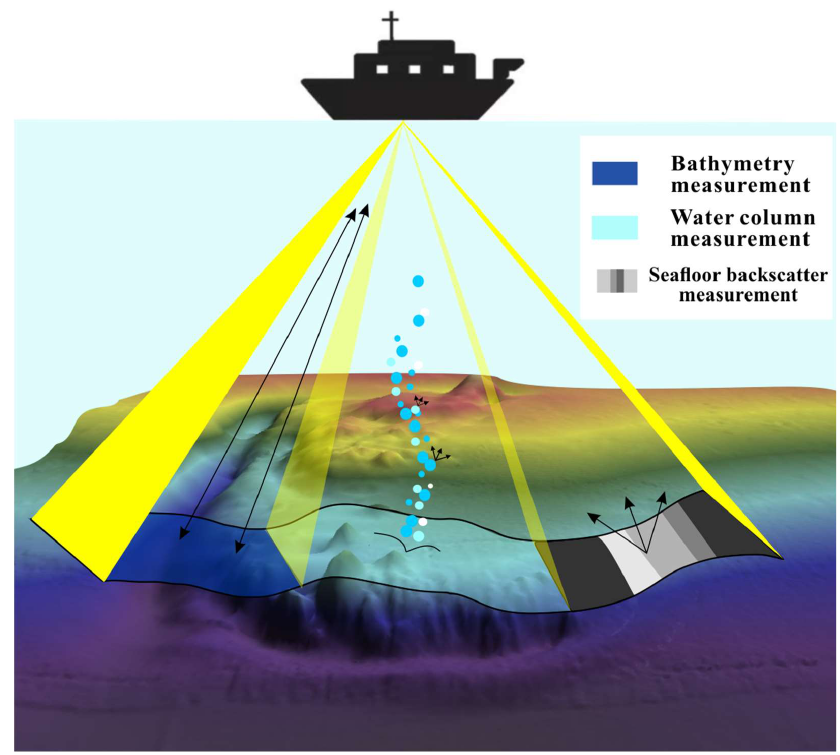
Figure 1. A diagram of different types of acoustic data recorded by MBES. Adapted with permission from ref. [7]. Copyright 2014 Copyright Colbo.